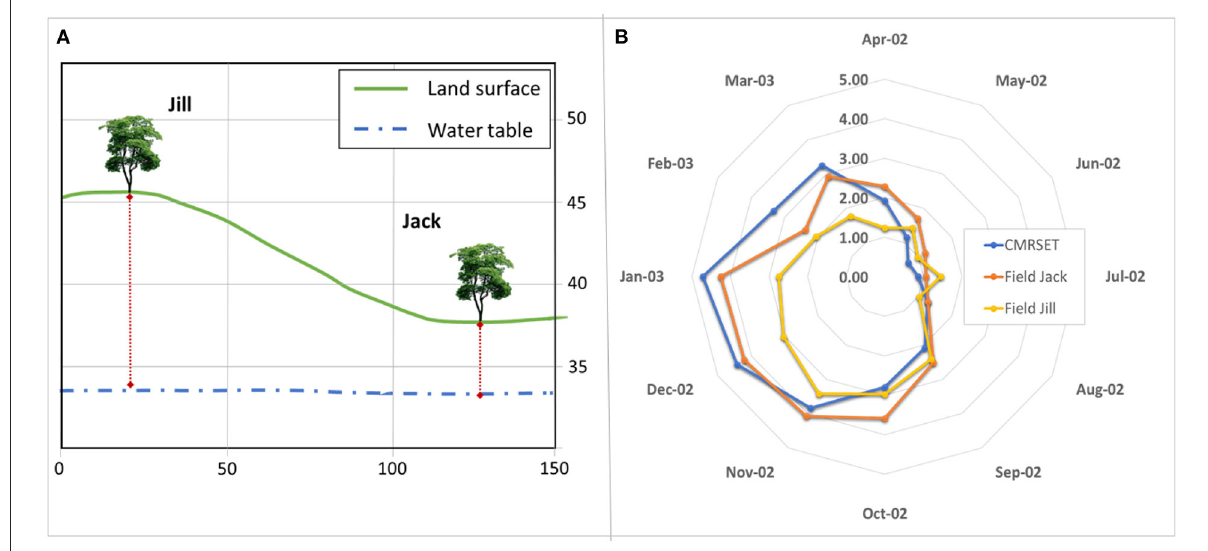
FIGURE2 Conceptual representation of the local undulation affecting the depth to WT (A) . Daily Actual ET from the CMRSET (averaged over 1 km 2 ) and daily actual ET from field data at Jack and Jill (B) .